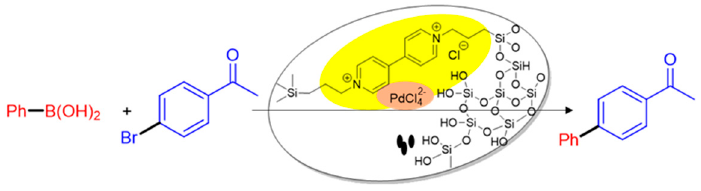
5 of 11 Figure 3. Pd@Bipy–PMO: ( a ) small angle X–ray diffraction (SAXRD) pattern, ( b ) EDX spectrum, and ( c ) nitrogen adsorption–desorption isotherms (BET) surface area and ( d ) Barrett–Joyner–Halenda (BJH) absorption.